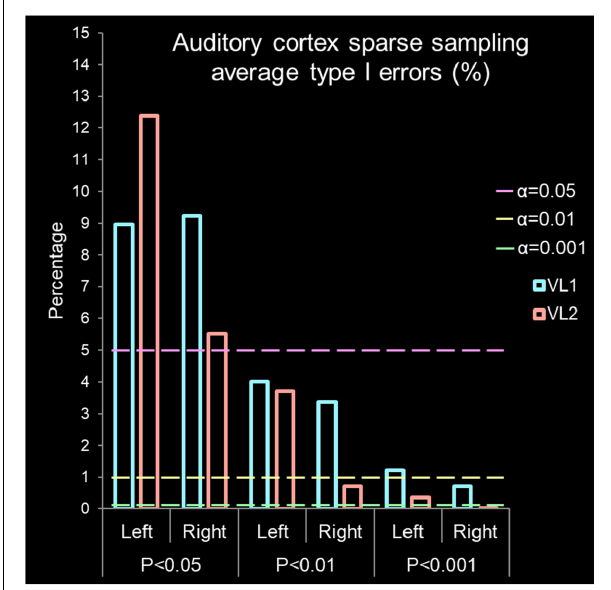
FIGURE 5 | Auditory cortex sparse sampling of silence. Average type I error percentage derived from activation/deactivation maps ( Figure 4a ). The bars are observed type I errors from the left and right hemisphere grouped by P- values. The x-axis is grouped volume, represented by VL1 (#98f5ff cadet blue) or VL2 (#ffa298 Salmon pink) and by P -values ( P < 0.05, P < 0.01, and P < 0.001). The y-axis is percentage of false positives found if accepting a specific alpha ( α ) value where the lines represent α = 0.05 (#ff98f5 light magenta), α = 0.01 (#f5ff98 light yellow), and α = 0.001 (#98ffa2 light green). The expected type I error α rate is found by dashed lines for α = 0.05, α = 0.01, and α = 0.001. Above these lines for an accepted P -value, a type I error has been committed. Therefore, rejecting the null hypothesis (indicating there is a difference) when no relevant BOLD activation/deactivation is